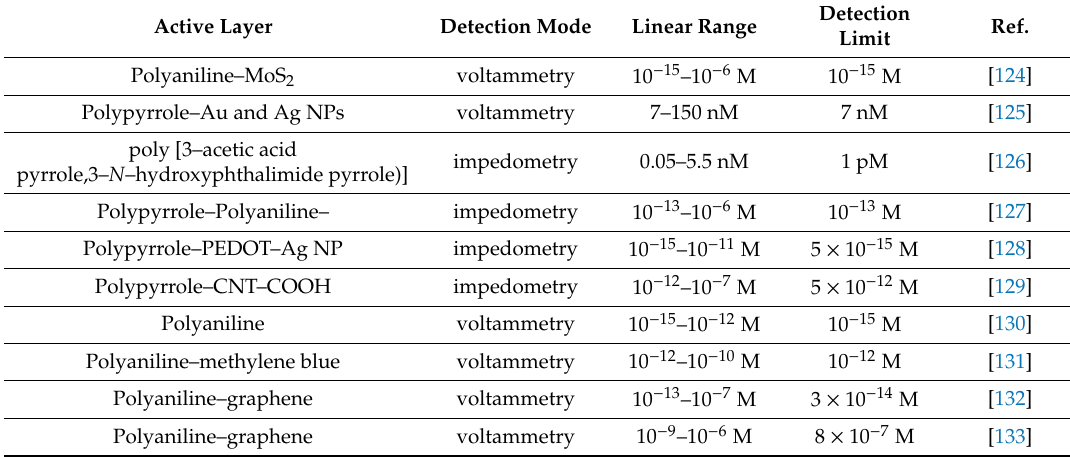
Table 4. Comparison of conducting polymer-based DNA biosensor